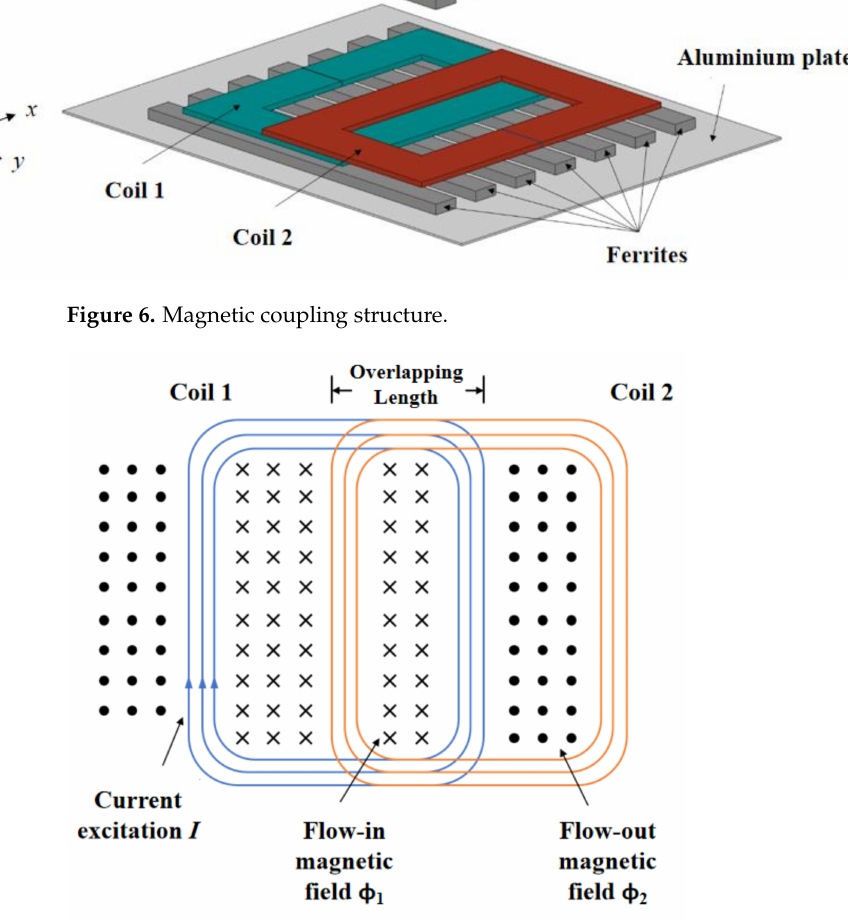
Figure 7. Decoupling mechanism of two transmitter